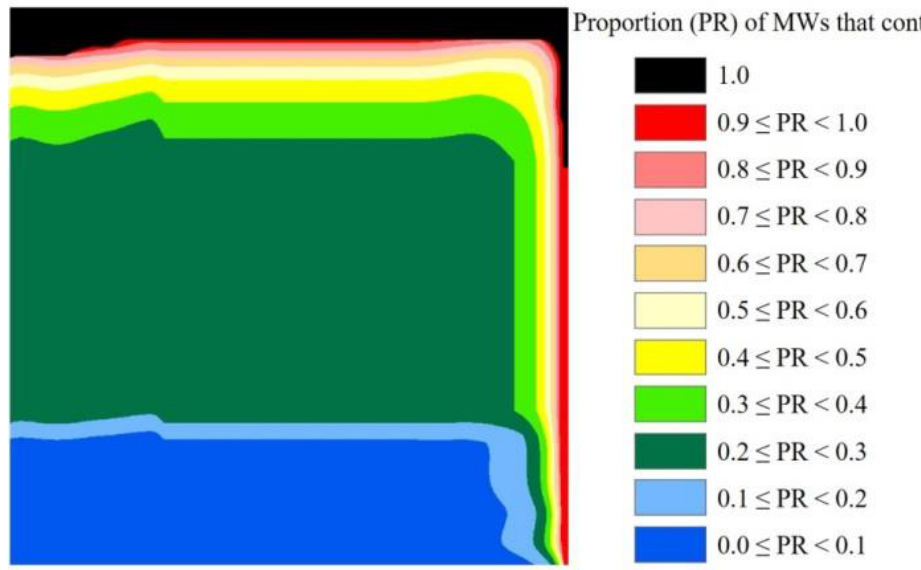
Figure 6. The edge effected region (EER) with reduced fire frequency (RFF; black region) identified in the GFF 1200 map by the moving window (MW) method. For each grid, the color indicates the proportion of the MWs within which it is located that contained an EER with RFF.